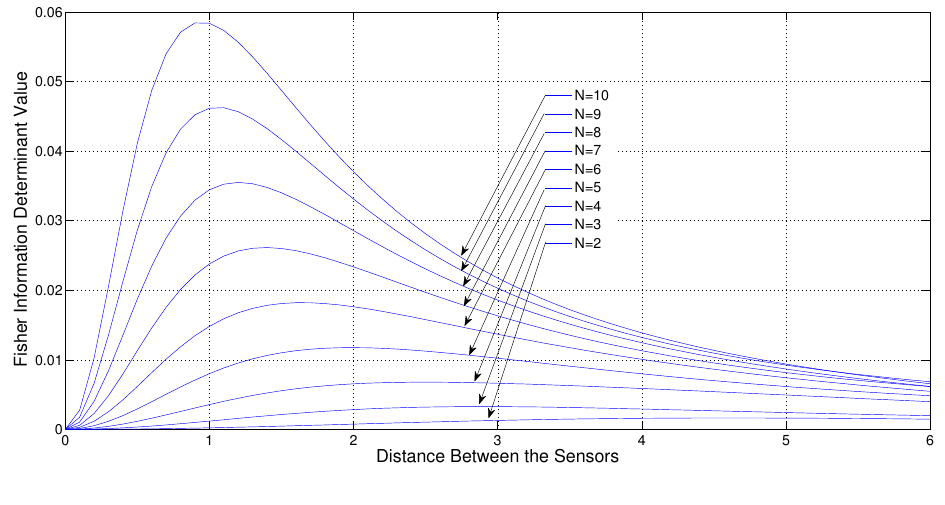
Figure 7. Variation of Fisher information determinant value with the distance between two adjacent sensors of ULA for different number of AoA sensors (All adjustable).